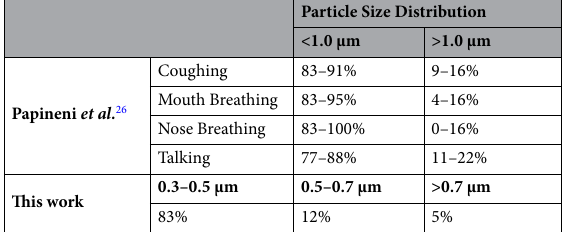
Table 3. Example of particle size distributions from humans during various activities are given 26 along with the averaged measured values for this